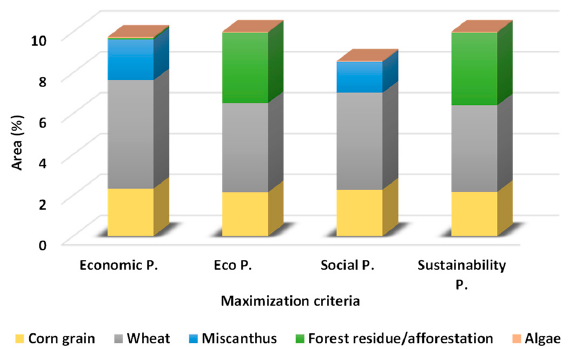
Figure 6. Usage of available area when applying different maximization criteria for Scenario 2.